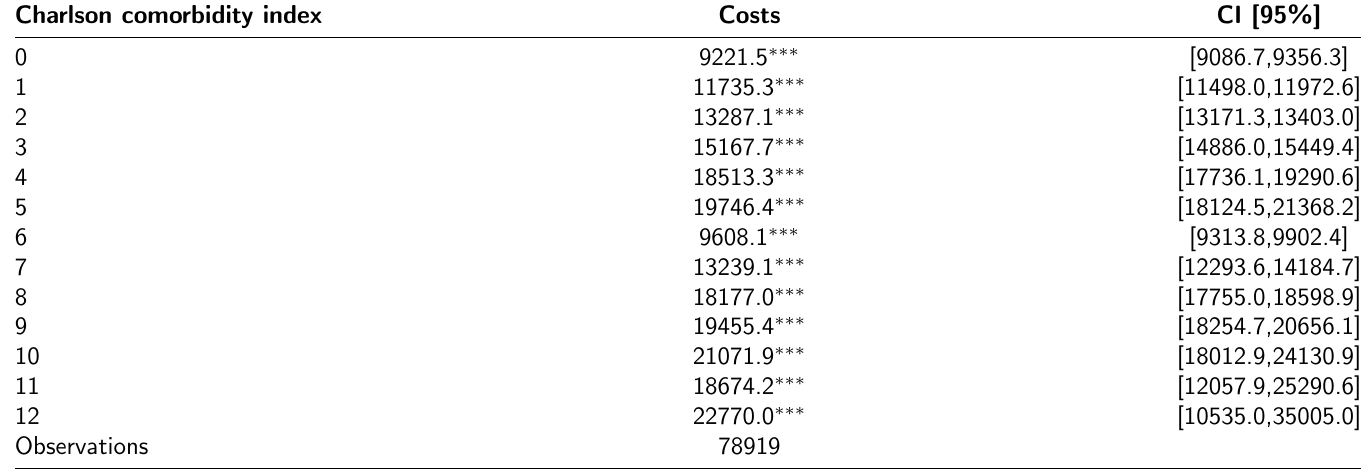
Supplementary Table 5: Univariate analysis GLM - Comorbidity (Charlson score 0 to 12)